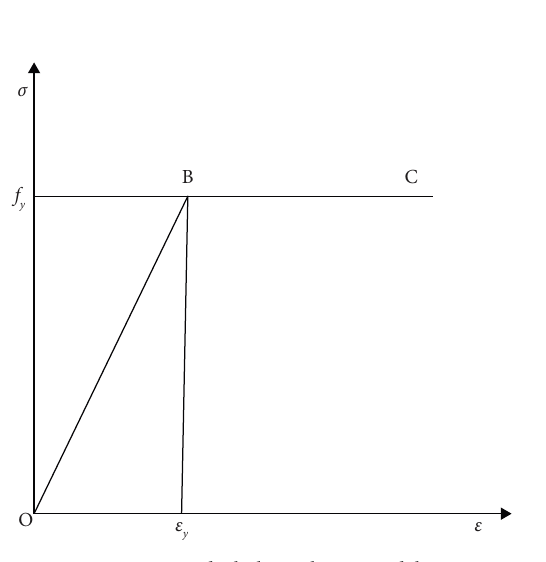
Figure 9: Ideal elastoplastic